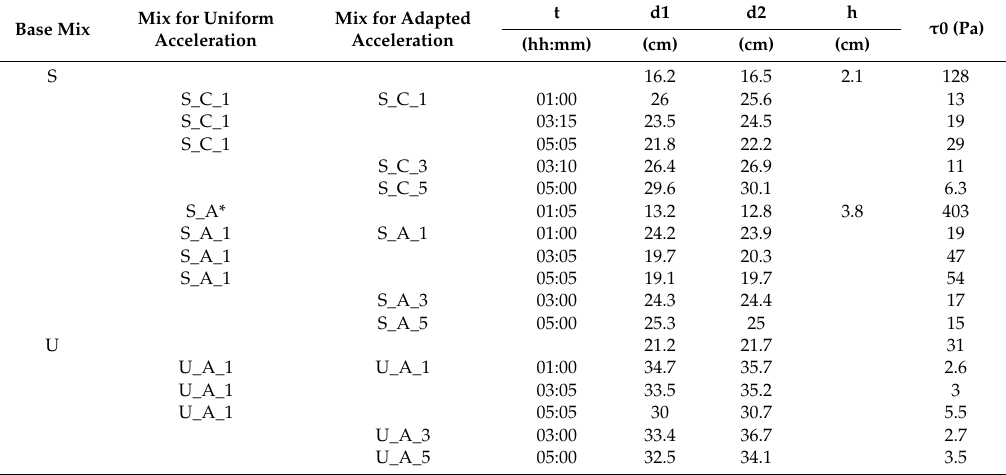
Table A1. Spread flow measurements of the di ff erent retarded and accelerated